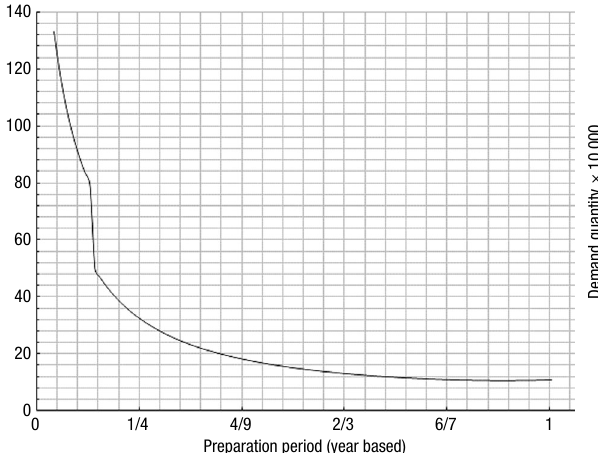
Fig. 5. Simulation of the trigger moment for the change of EM, considering different preparation periods to support the